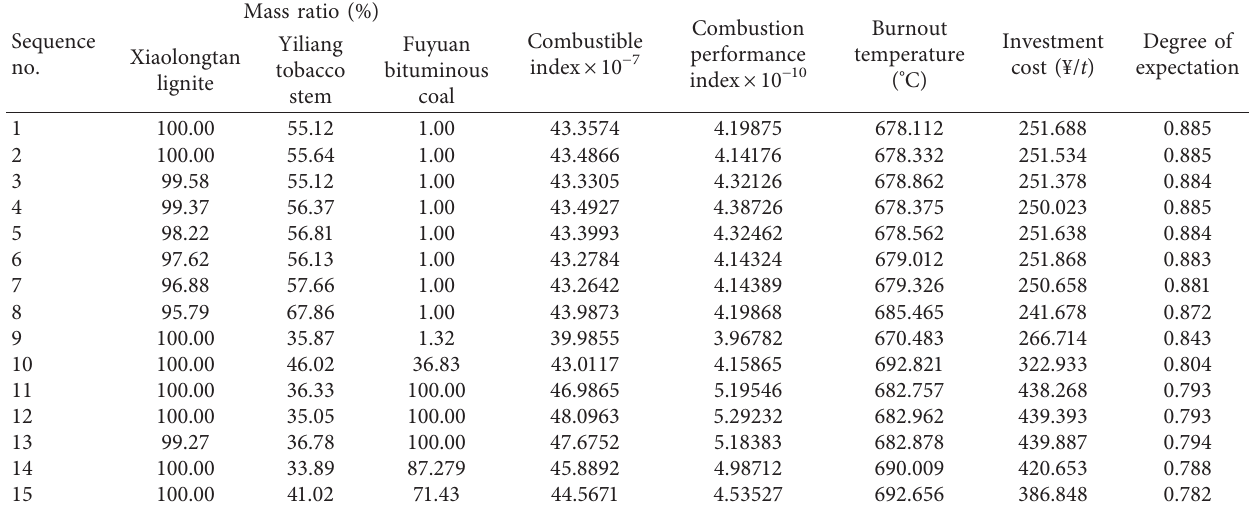
Table 13: Comprehensive optimization scheme of each